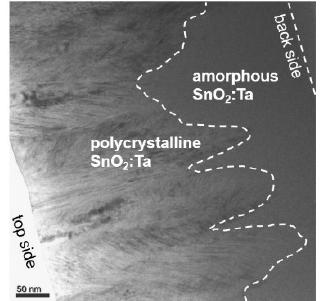
Figure 8. Cross-sectional transmission electron micrograph of a ≈ 500 nm thick SnO 2 :Ta film. The flat interface to the glass substrate and the corrugated interface between the amorphous (bottom) and the polycrystalline (top) parts of the film are marked by dashed lines. The image was taken in the bright field modus, including diffraction contrast and zero-energy-loss filtering. Deposition parameters: P RF = 100W, p = 0.5Pa, RT, Ar+N 2 O.